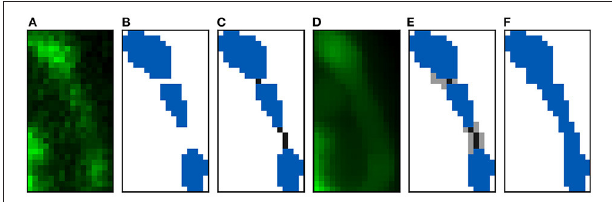
FIGURE 5 | Reconstruction algorithm steps: (A,B) Show the clipped maximum projection of a spine composed of three components. (A) Shows the confocal image and (B) its reconstruction. (C) Displays the two paths created to join the three components. (D) Shows the confocal image after applying a median filter. The flooding phase results can be found in (E) . Finally, (F) illustrates the final